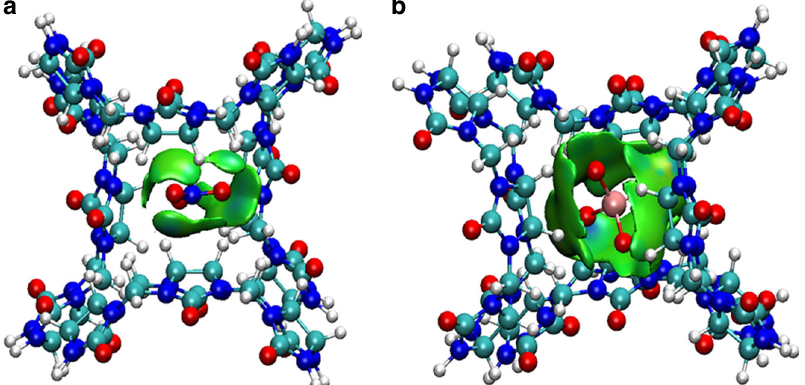
Fig. 8 Intermolecular interactions (isosurfaces: 0.005 a.u.) for different models using IGM analysis. a CB8-based host [ H ] and NO 3 − ; b CB8-based host [ H ] and ReO 4 − (blue represents a strong attraction, and red denotes a strong repulsion). All isosurfaces are colored according to a BGR (blue-green-red) scheme over the electron density range − 0.05 < sign( λ 2 ) ρ < 0.05